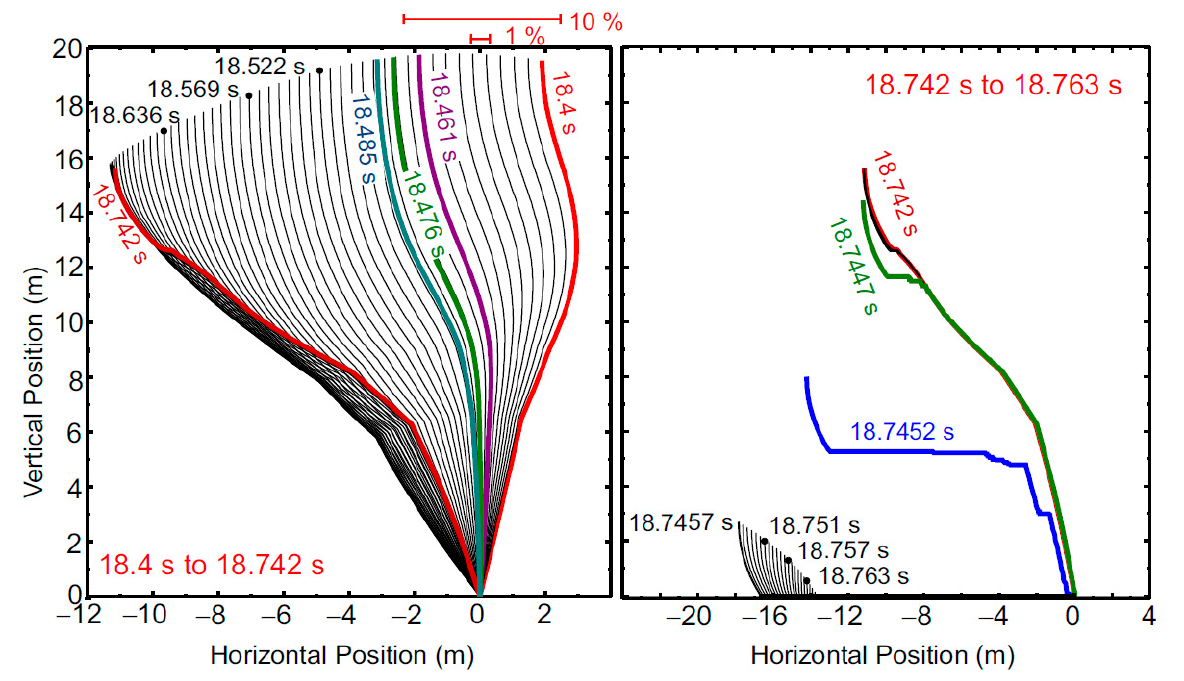
Figure 17. Movement of the building just before the final collapse ( left ), and the rapid collapse sequence between 18.742 s and 18.763 s ( right ).